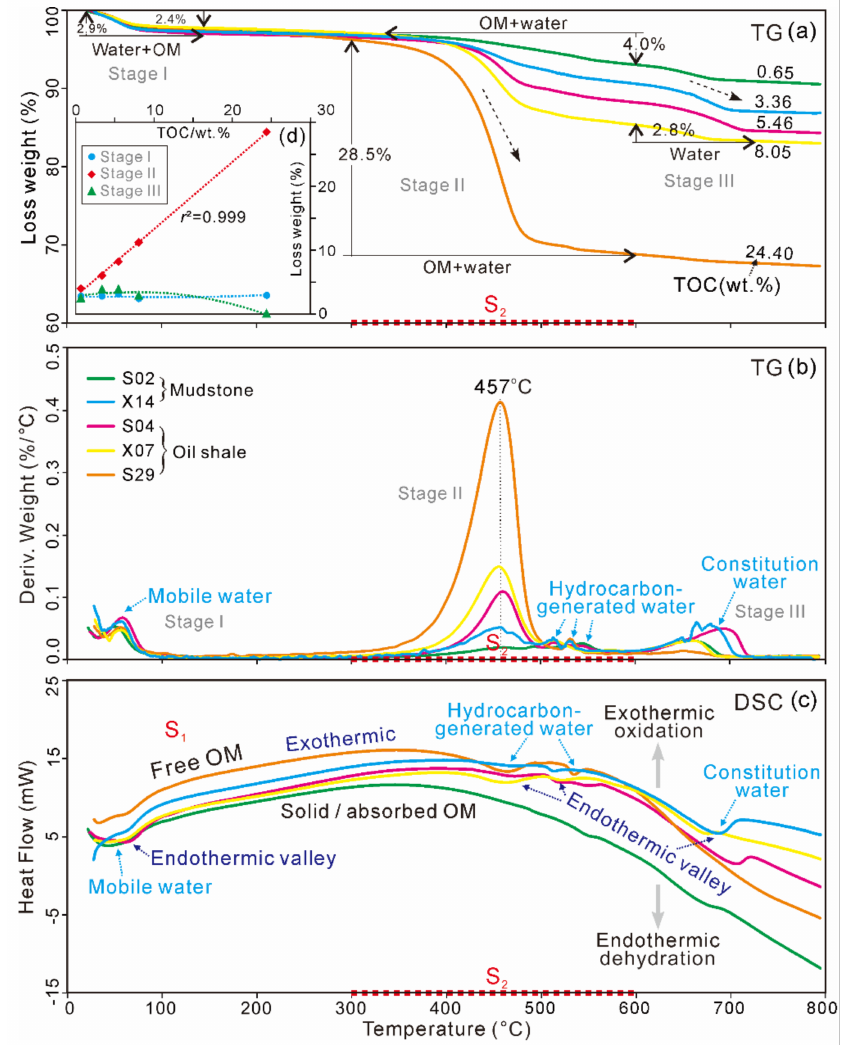
Figure 7. The curve distribution of loss weight ( a ) and derivative weight ( b ) from thermogravimetry (TG), heat flow from differential scanning calorimetry (DSC) ( c ), plot of TOC and loss weight ( d ) for oil shales and mudstones in boreholes Ngn2 and ZK3389 (after